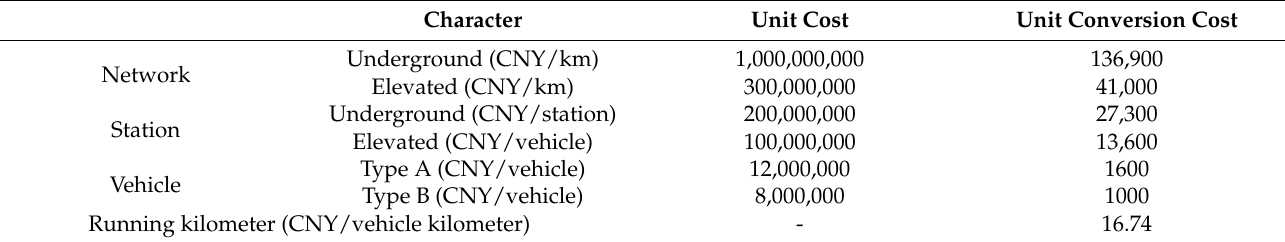
Table 1. Cost of urban rail